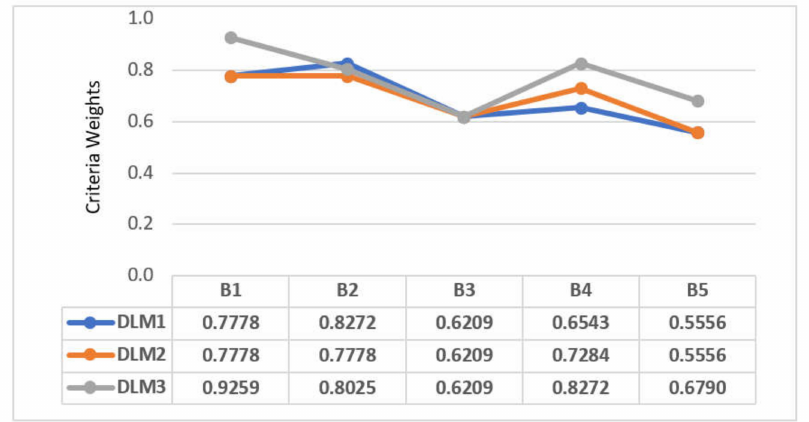
Figure A2. The study results of quality assessment for three distance learning modules—DLM1, Research methodology and statistical analysis; DLM2, Social Statistics; DLM3,Political Science Research Methodology—by five criteria according to information tools usage ( B ): B 1 = assessment calculation tools for knowledge testing; B 2 = material scanning and availability; B 3 = the possibility of personalizing the learning process; B 4 = assistance that can be given to the student; B 5 = resources of synchronous and asynchronous